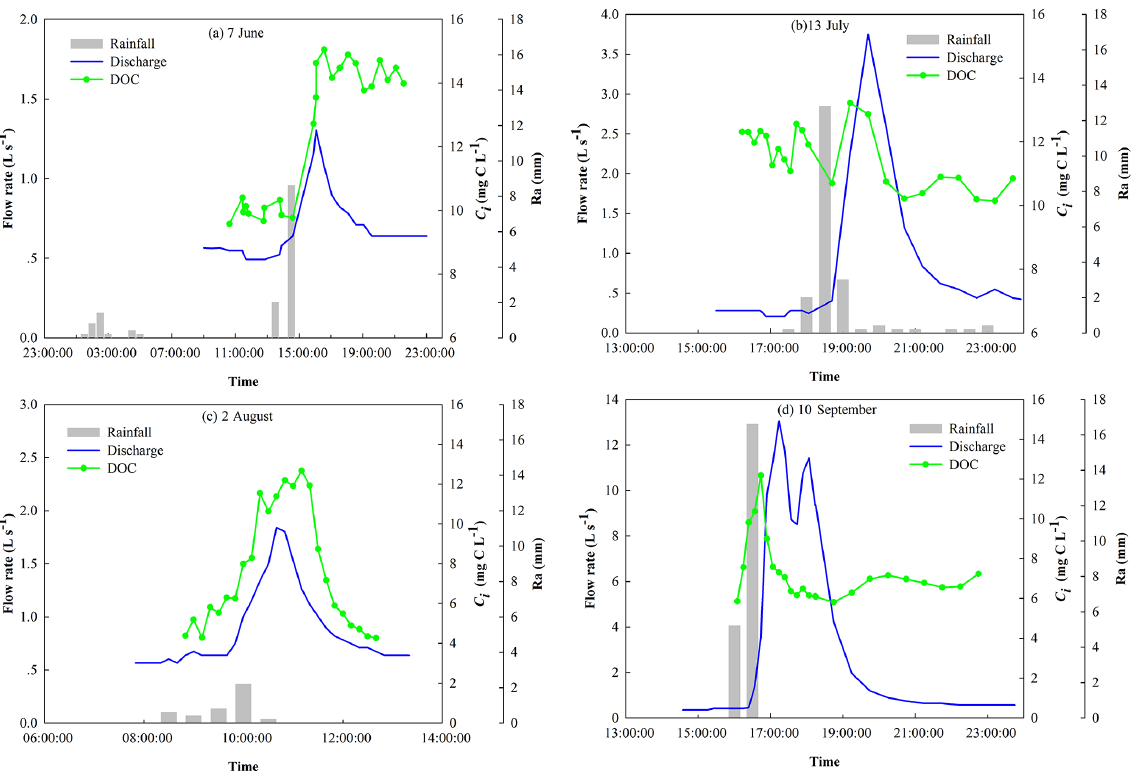
Figure 5. Dynamic changes of DOC concentration ( C i ) in an individual runoff event: (a) 7 June, (b) 13 July, (c) 2 August, (d) 10